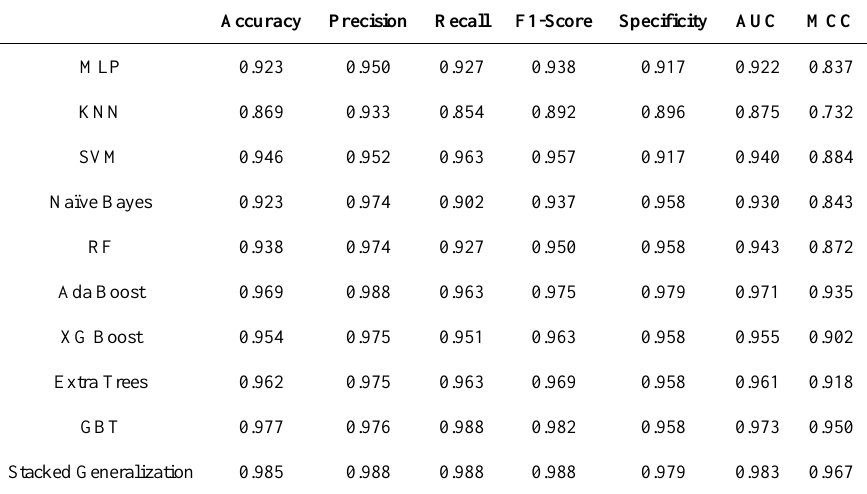
Table 7. Performance of various base learners on Early-stage dataset Accuracy